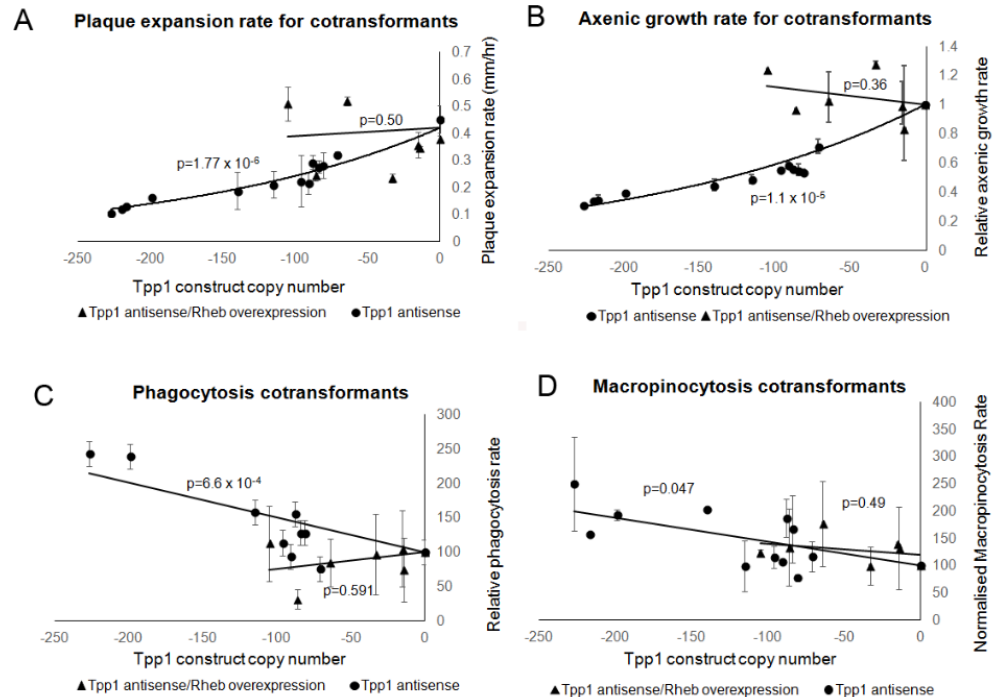
Figure 11. Overexpression of Rheb rescued the growth and endocytic defects caused by antisense inhibition of Tpp1. Wild type, Tpp1 antisense and Tpp1 antisense/Rheb overexpression cotransformants were measured for their growth ability and their endocytosis rates. Negative copy numbers represent the number of Tpp1 antisense constructs ( A ) Cells were grown on E. coli B2 lawns and the diameter of each Dictyostelium plaque was measured twice daily for 5 days and the rate of plaque expansion calculated. Three replicates were used for each strain and the experiments were repeated three times. Error bars represent standard error. ( B ) Cells were suspended to a final concentration of 1 × 10 4 cells·mL −1 and grown on a shaker at 21 °C. A small amount of medium containing Dictyostelium cells was removed and counted twice daily. Error bars represent standard errors. The experiment was repeated twice. The growth rate for each strain (generations/h) was then calculated. The data in (A,B) show that, whilst growth is significantly affected in the Tpp1 antisense transformants, no significant difference in growth was observed in the Tpp1 antisense/Rheb overexpression transformants and wild type cells indicating that overexpression of Rheb rescues the Tpp1 mediated growth defect. ( C ) The ability of cells to ingest a fluorescently labelled bacterium (DsRed-expressing E. coli ) was measured and results were normalised to wild type. The experiments were repeated a minimum of three times and error bars represent standard error. ( D ) The rate of uptake of medium containing the fluorescent marker FITC-dextran was measured and values were normalised against the wild type. The experiments were performed at least three times and error bars represent standard errors. Data in (C,D) show that endocytosis was significantly affected in the Tpp1 antisense inhibited strains and this defect was rescued by overexpression of Rheb. The regressions were significant at the indicated p values (t test). The lines for the Tpp1 antisense/Rheb overexpression cotransformants in all the panels were fitted by the linear least squares method. The lines for the Tpp1 antisense strains in (A,B,D) were fitted by the least squares method to an exponential equation and in (C) to a linear equation.